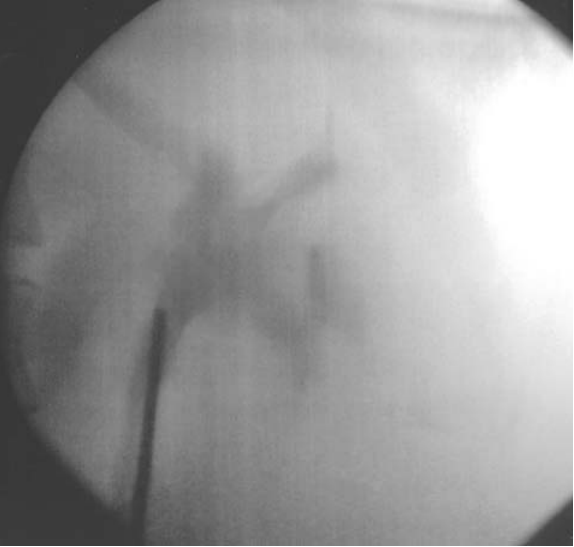
Figure 6 – Retrograde pyelography after balloon